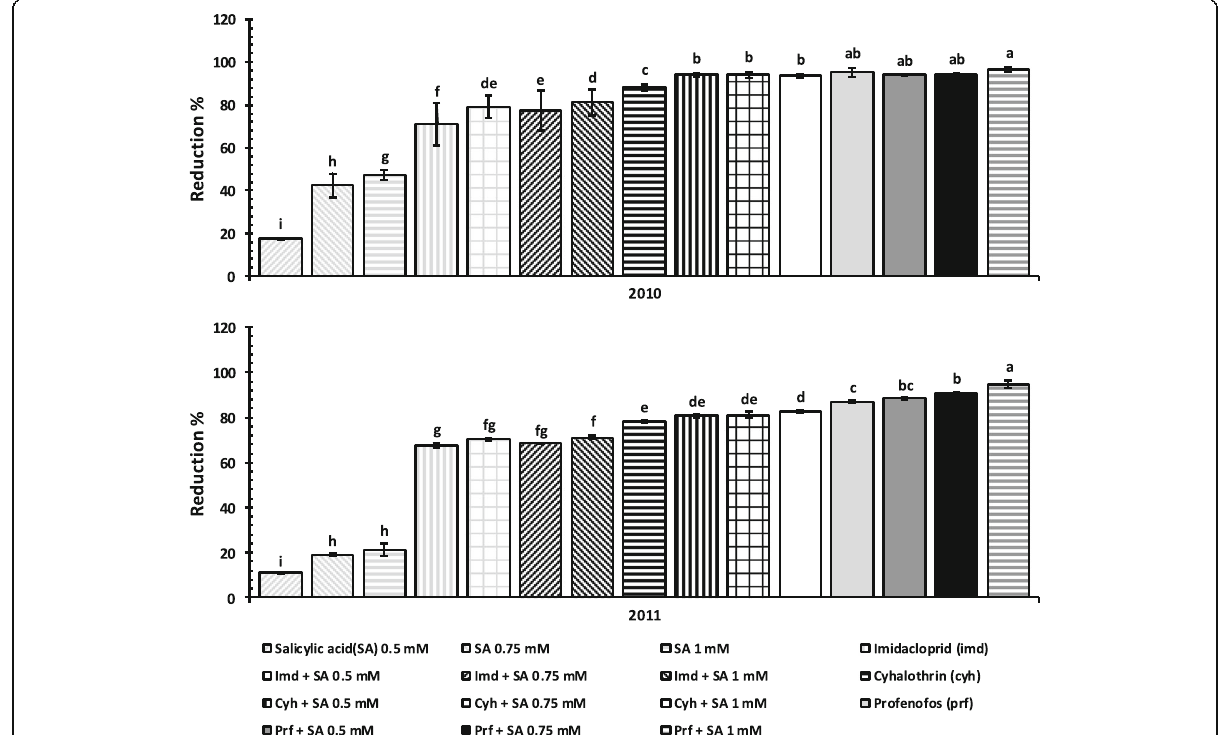
Fig. 1 Efficiency of certain insecticides and/or salicylic acid combination against the cotton aphids, Aphis gossypii , in cotton